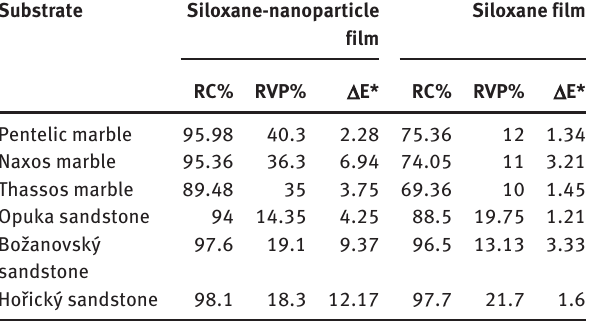
Table 4 Results of capillary water absorption, vapor permeability, and colorimetric measurements that were carried out on marble and sandstone specimens covered by superhydrophobic siloxane- nanoparticle and hydrophobic siloxane films. Measurements were carried out using Eqs. (7), (9), and